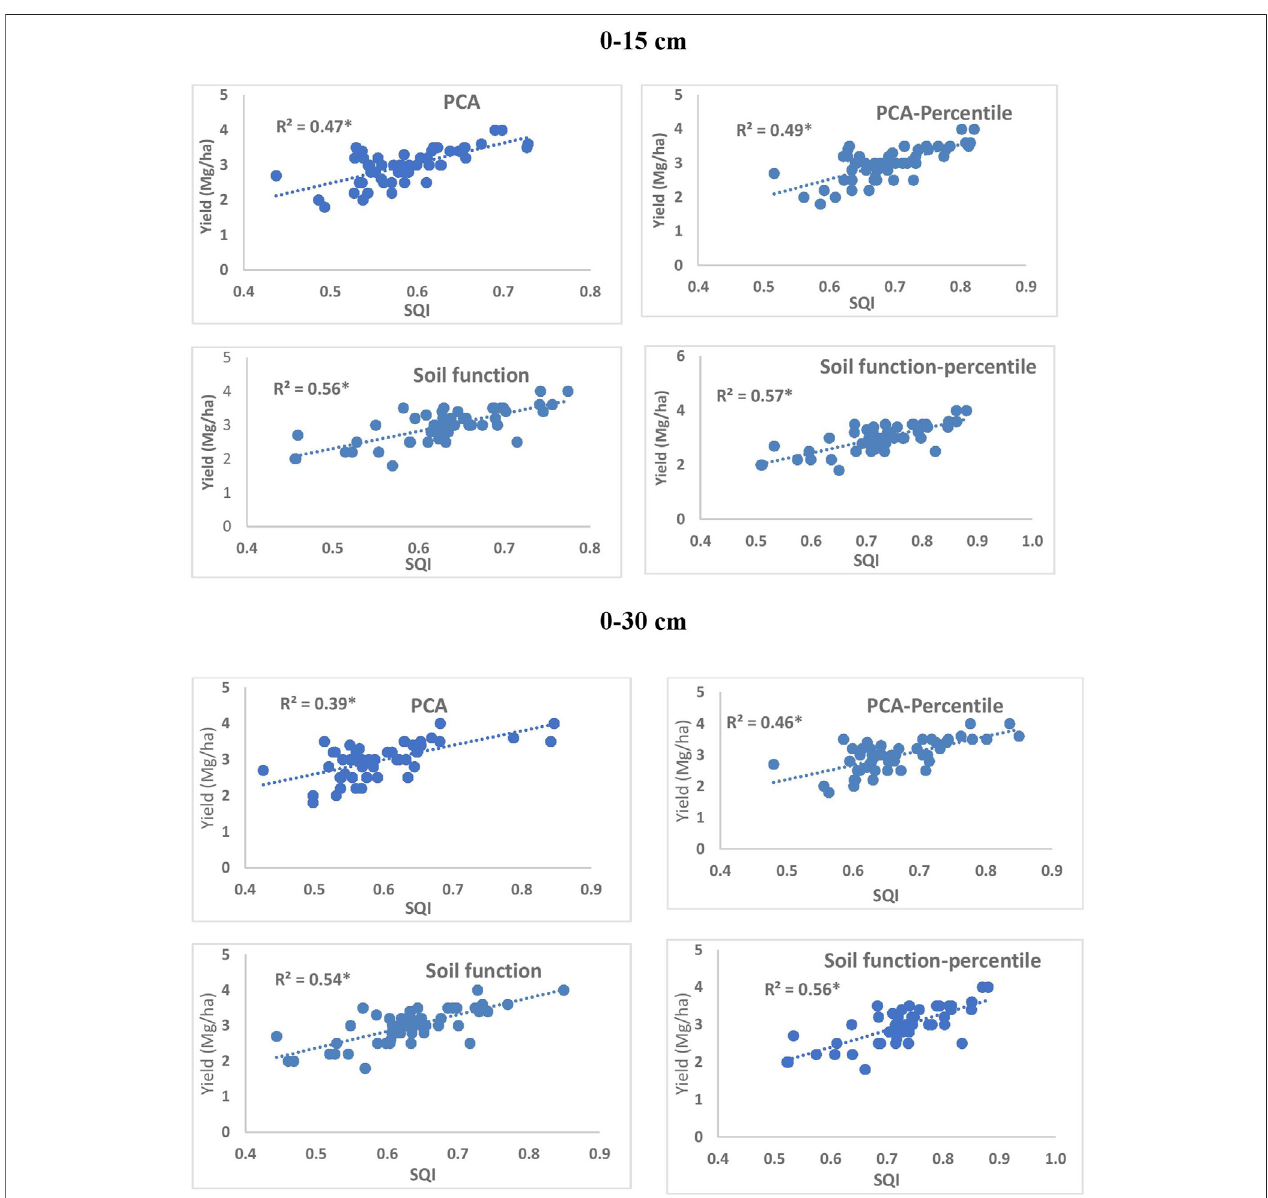
FIGURE 2 | Correlation of soil quality index (SQI) derived from the soil data of 0 – 15 cm and 0 – 30 cm with rice yield under the four different indexing methods ( n = 52).